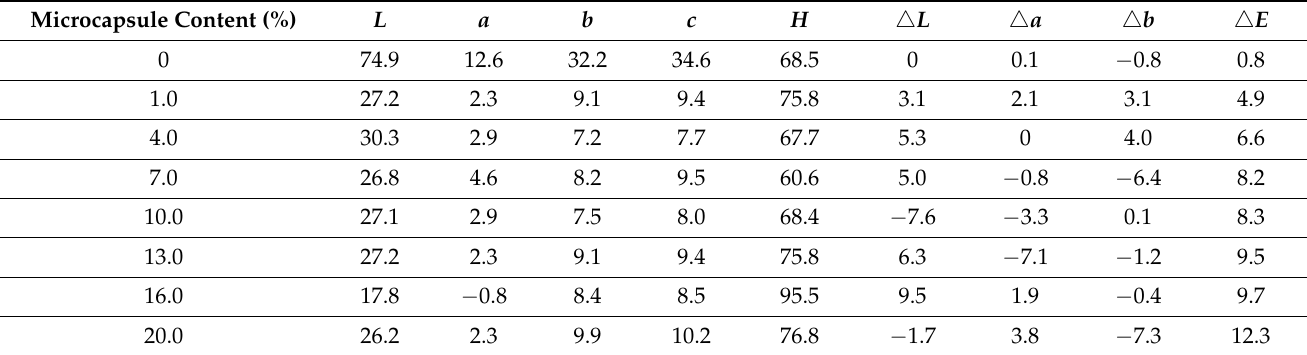
Table 8. Color values of the coatings with core-wall ratio of